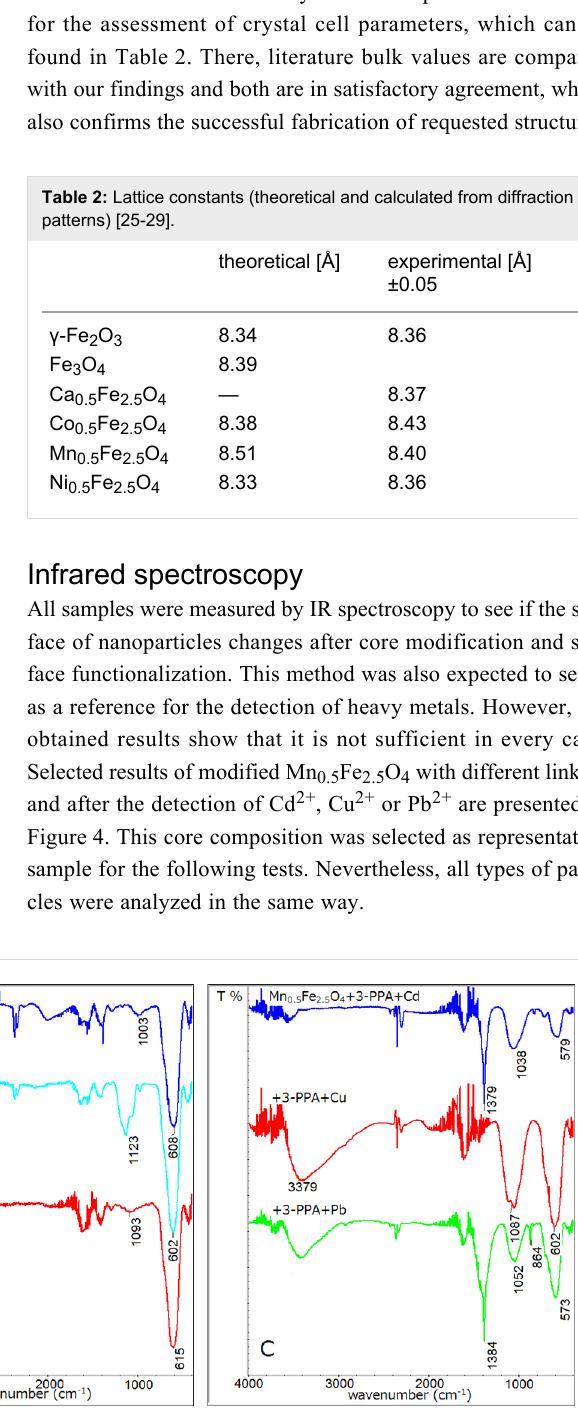
Figure 4: The IR spectra of Mn 0.5 Fe 2.5 O 4 nanoparticles A) with various linkers used in the experiment, B) with attached SA and Cd, Cu and Pb; and C) with attached 3-PPA and Cd, Cu and Pb.